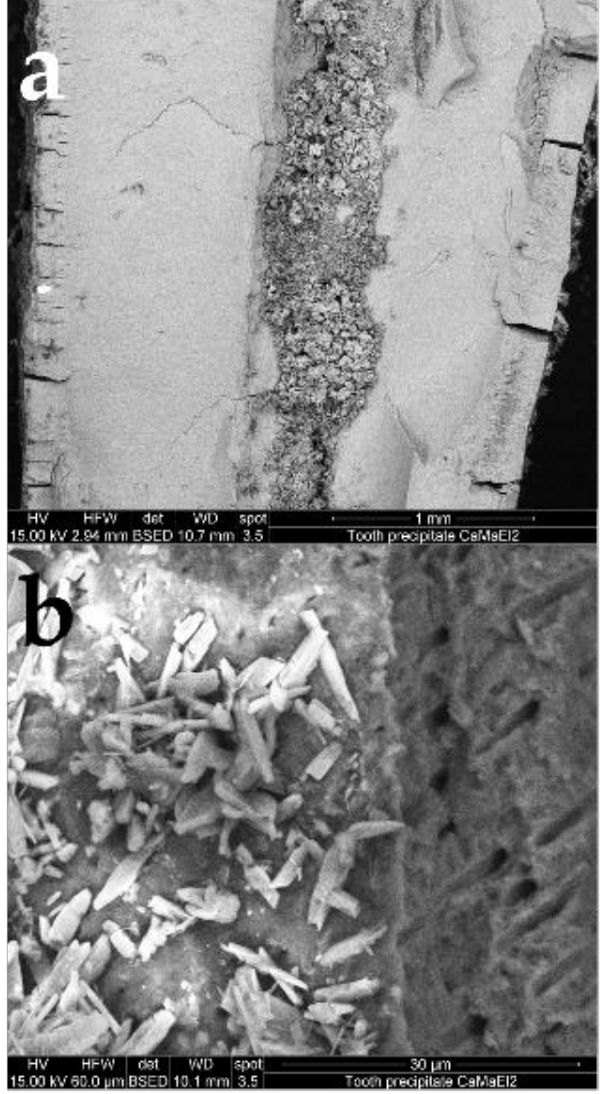
Figure 11. SEM image of tooth split in half after CaP obturation. The tooth was dried at 65 °C for 48 h prior to SEM imaging. Loose crystals were removed using compressed air. ( a ) Filled root canal; ( b ) crystals attaching to the root canals sealing the dentin tubules (left: crystals at the root canal surface; right: cross section of the dentin tubules). BSED: back-scatter detector .